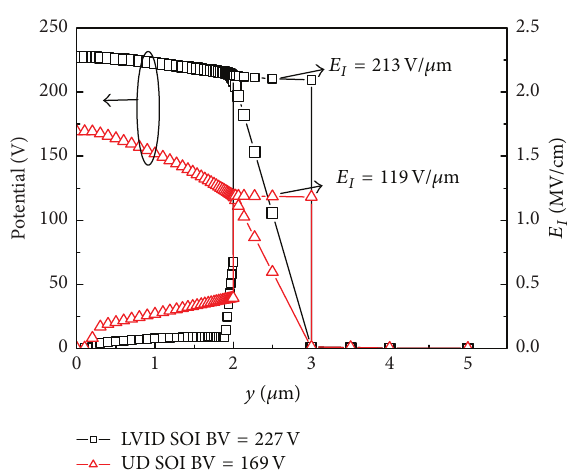
Figure 4: Vertical electric fields and potentials distributions at breakdown along line MN for UD SOI LDMOS ( 𝑁 𝑑 = 9 × 10 15 cm −3 ) and LVID SOI LDMOS ( 𝑁 𝑑 = 4 × 10 15 cm −3 , 𝐺 = 4.48 × 10 20 cm −4 ).